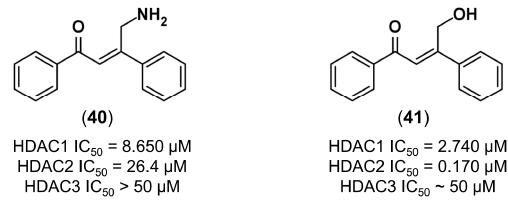
Figure 14. Time-dependent histone deacetylase 2 selective inhibitors identified by integration of quantum mechanics and quantum mechanics/molecular mechanics strategies [147].